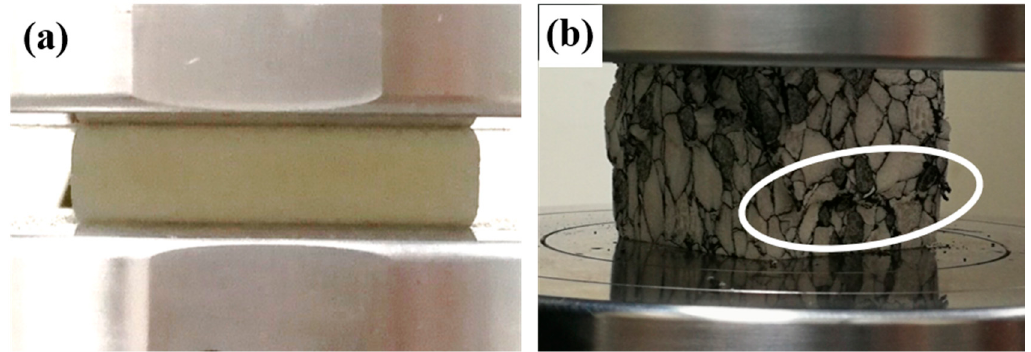
Figure 4. Images of PMI foams during compression. ( a ) PMI foam at compressive strain of 75%; ( b ) Absorbent PMI foam at compressive strain of 30%. The ellipse region shows where cracks occurred which subsequently caused collapse.